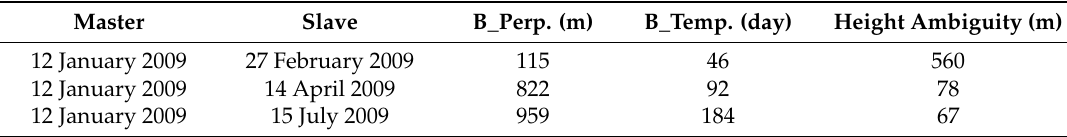
Table 1. Image pairs used for monitoring of Donghai Bridge. B_perp and B_temp represent the perpendicular baseline and time interval between the two acquisitions,